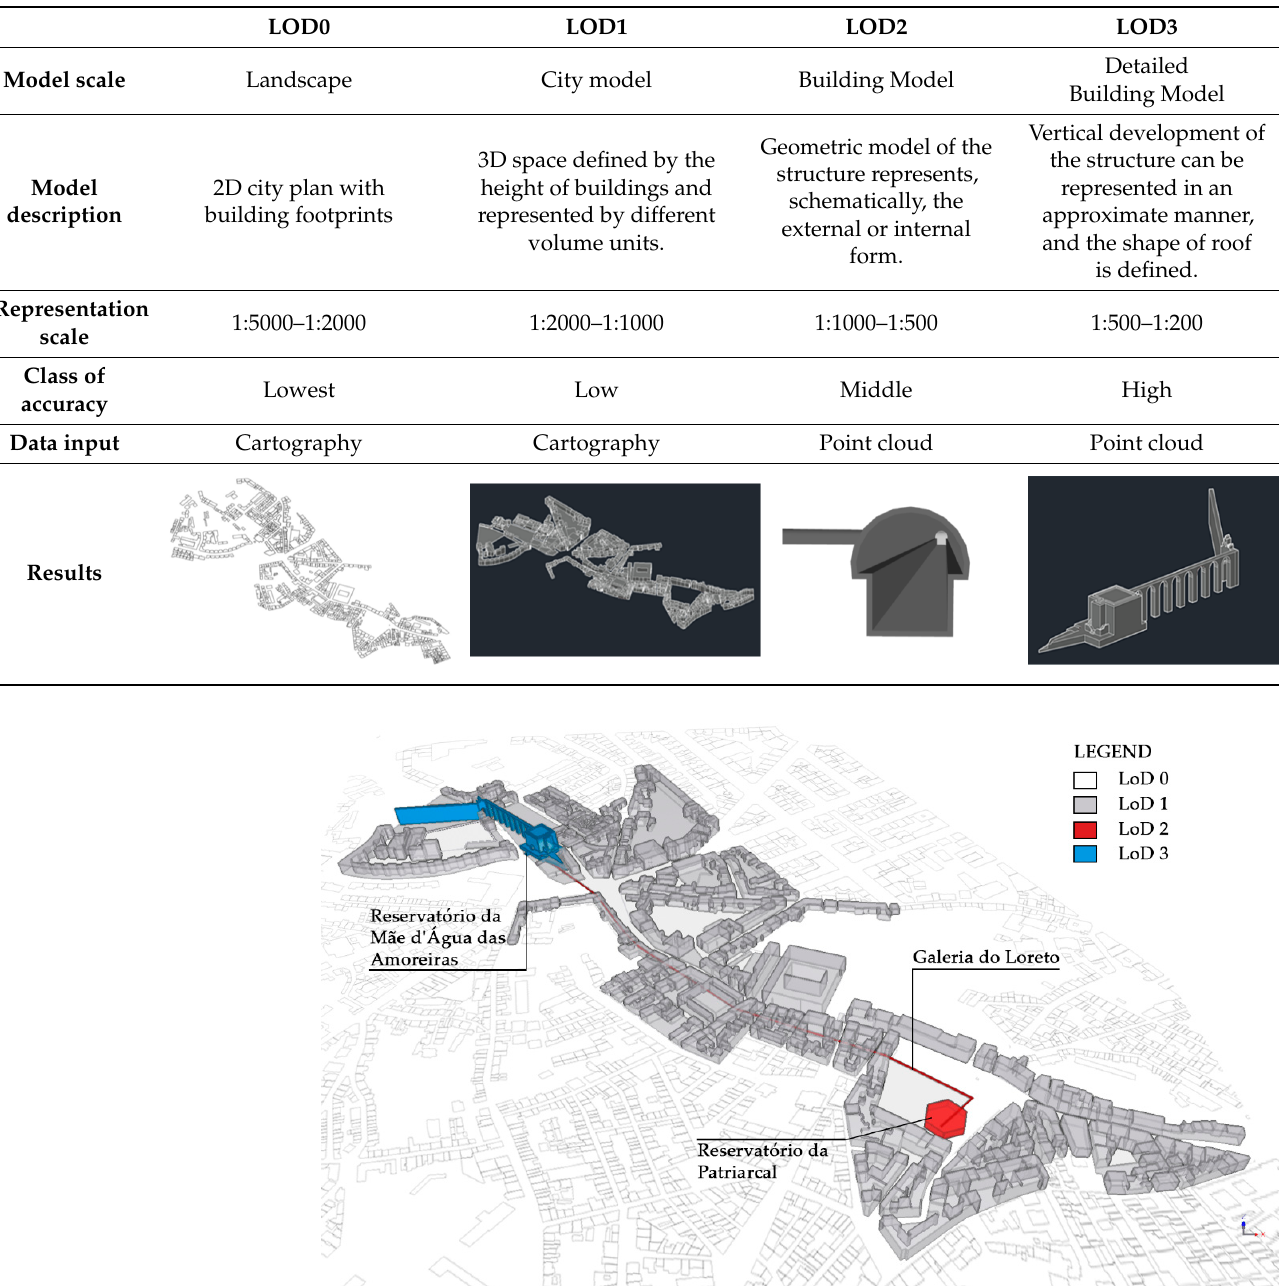
Table 6. Definition of LODs of modeled objects for 3D GIS.